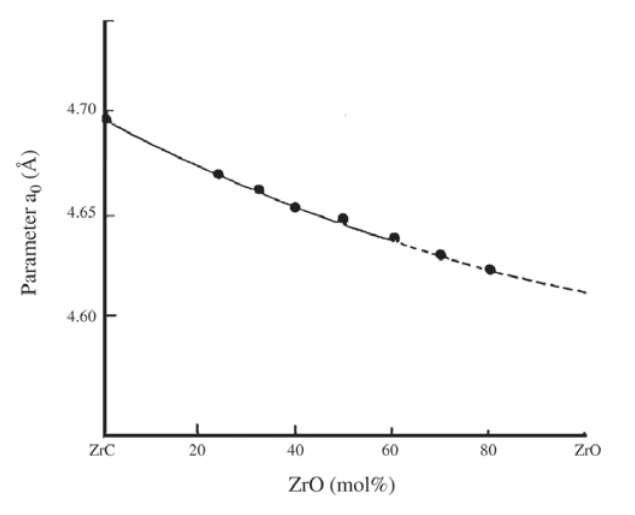
Figure 6. Unit-cell parameter a from Kosolapova et al. 4